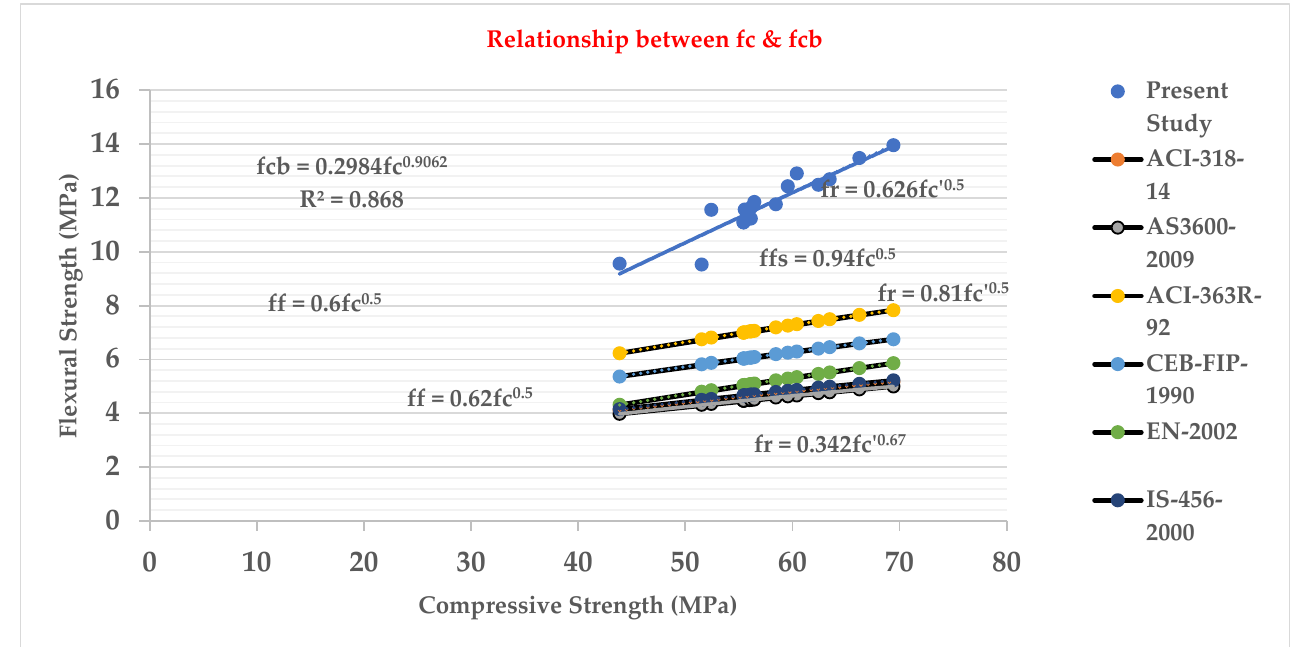
Figure 11. Relation between flexural strength and compressive strength.